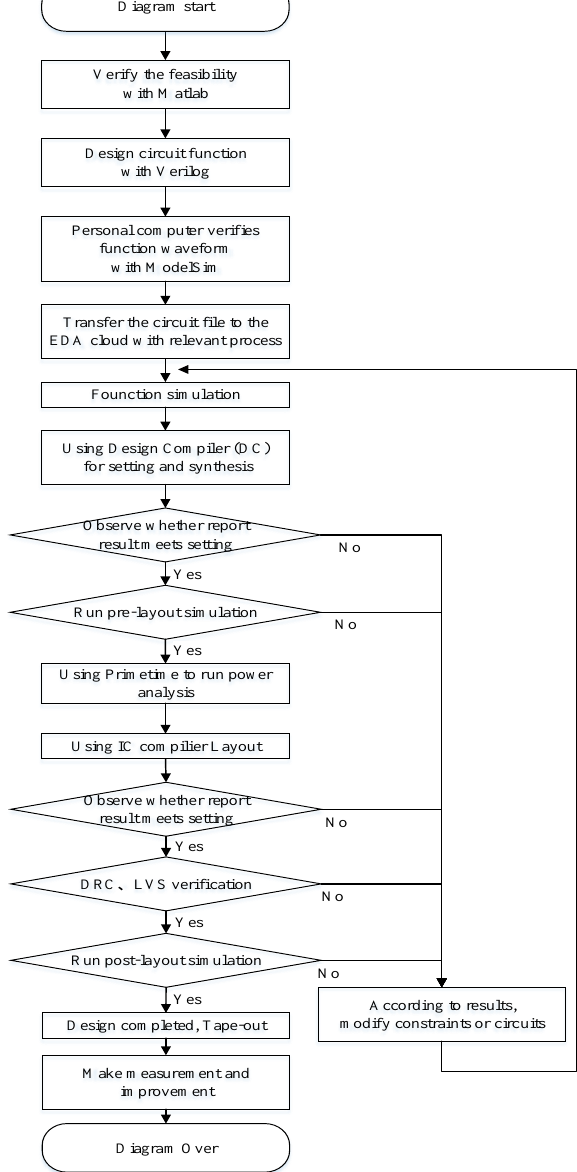
Figure 13. Circuit design and the diagram of tape-out.